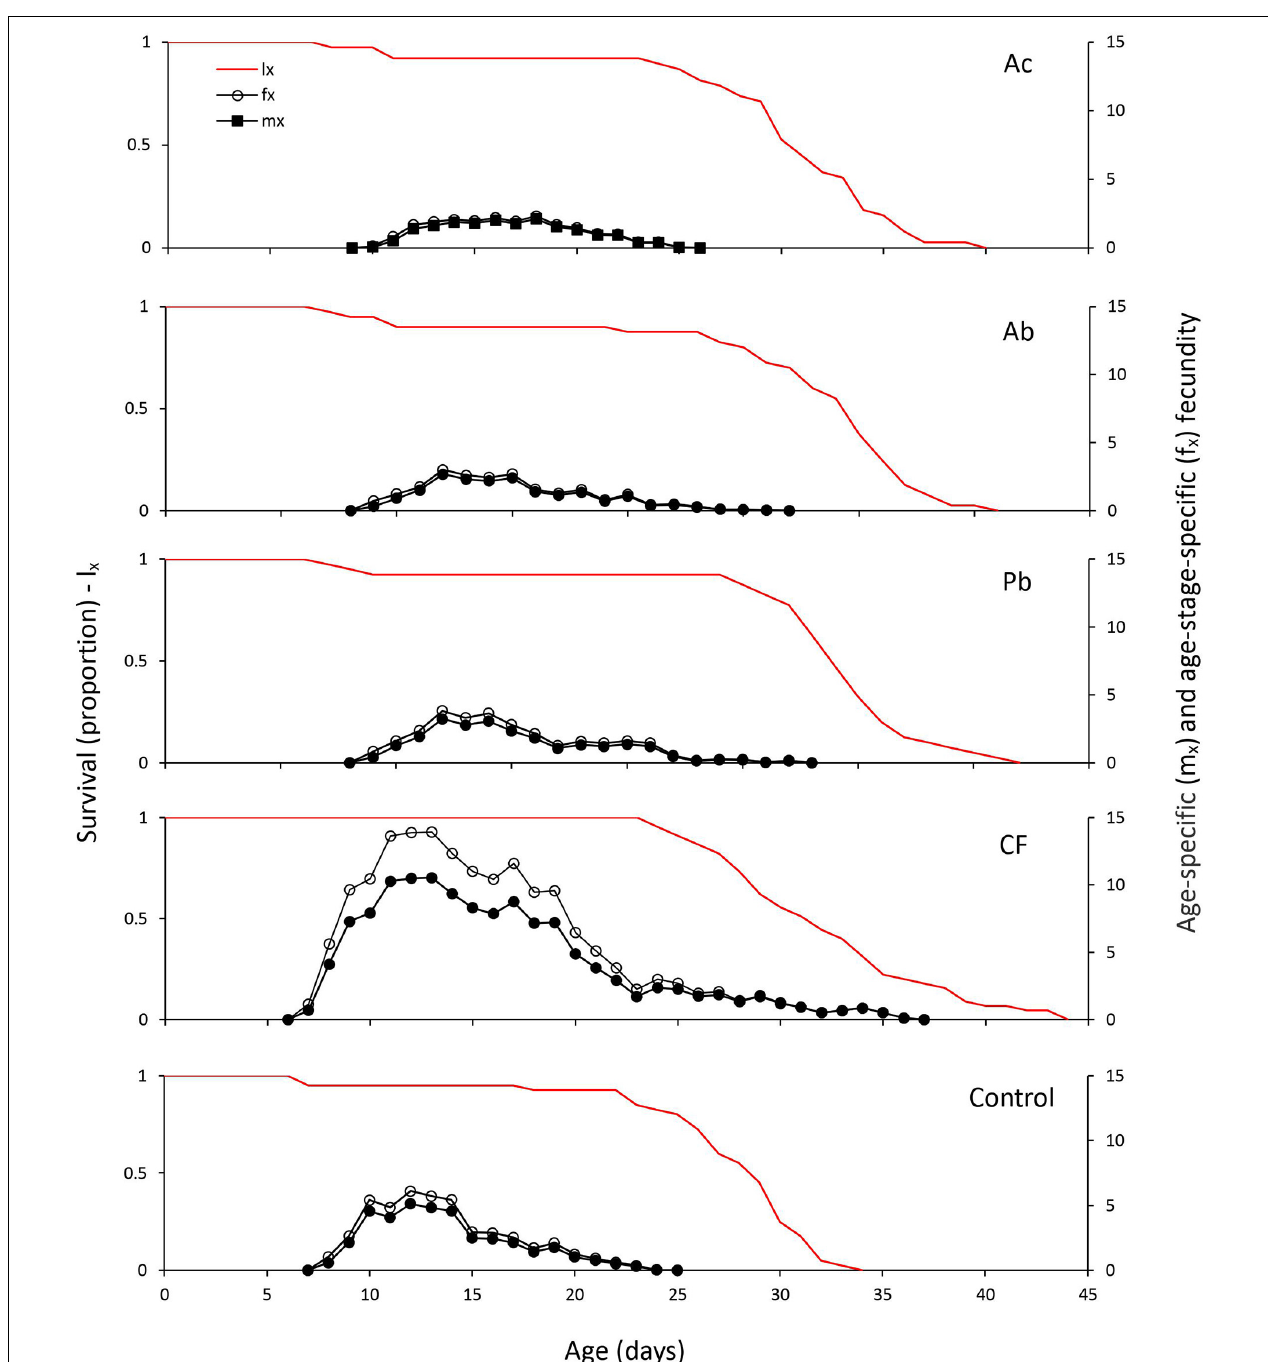
FIGURE 2 | Age-specific survival ( l x ) and fecundity ( m x , f x ) curves of T. urticae reared on leaves of strawberry plants subjected to one of five treatments, Ac ( Azotobacter chroococcum ), Ab ( Azospirillum brasilense ), Pb ( Pseudomonas brassicacearum ), CF (chemical fertilizer), and control